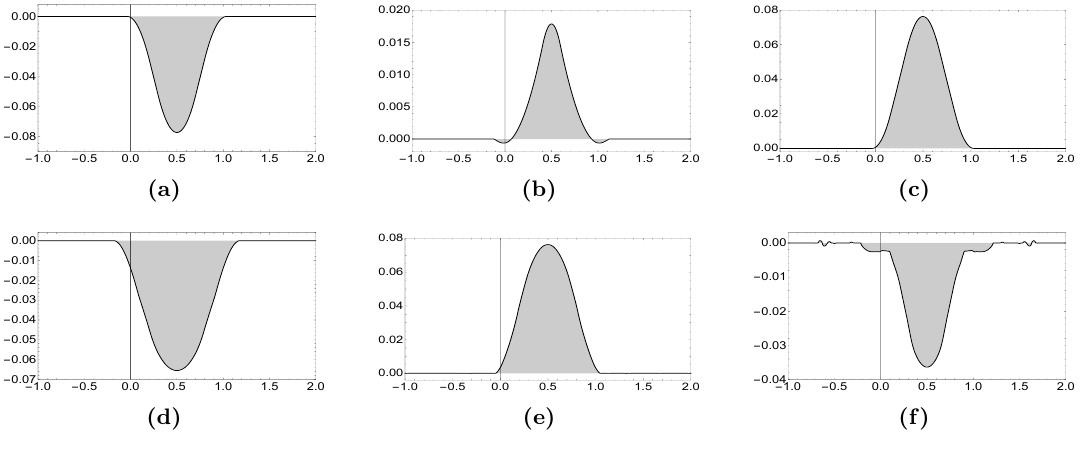
Figure 25. The perturbed signum-Gordon model for (cid:15) = 1 : 2 at (a) t = 0 : 2052, (b) t = 1 : 1350, (c) t = 5 : 4025, (d) t = 26 : 9678, (e) t = 27 : 5035, (f) t = 32 : 8919.